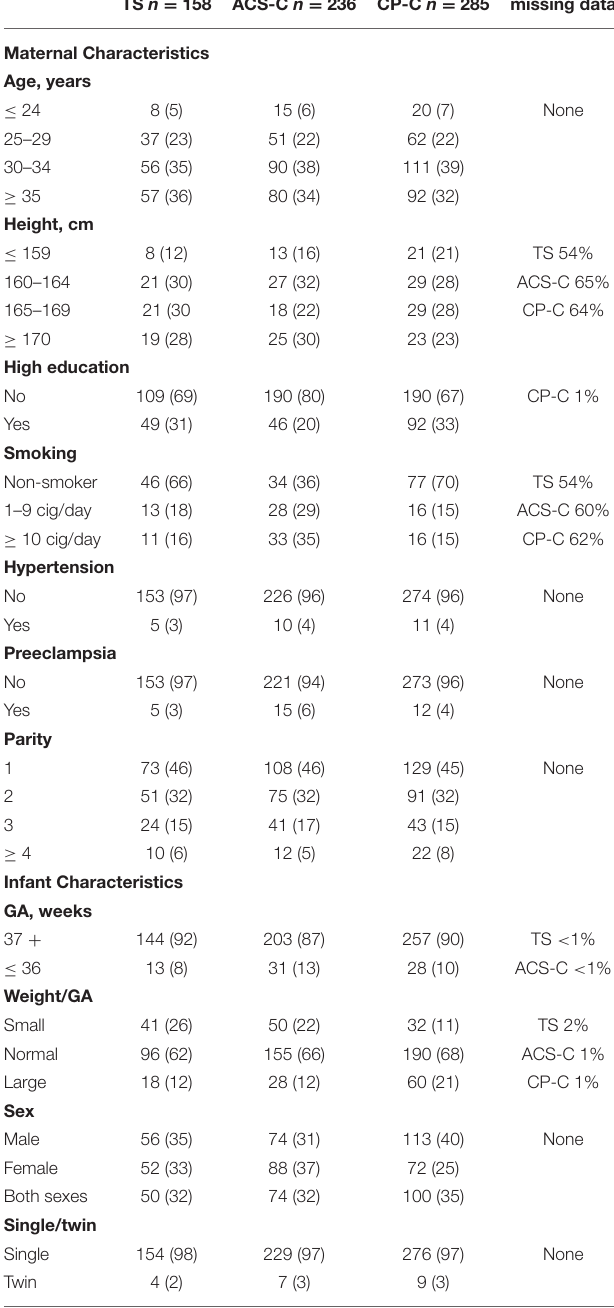
TABLE 1 | Maternal and infant characteristics by